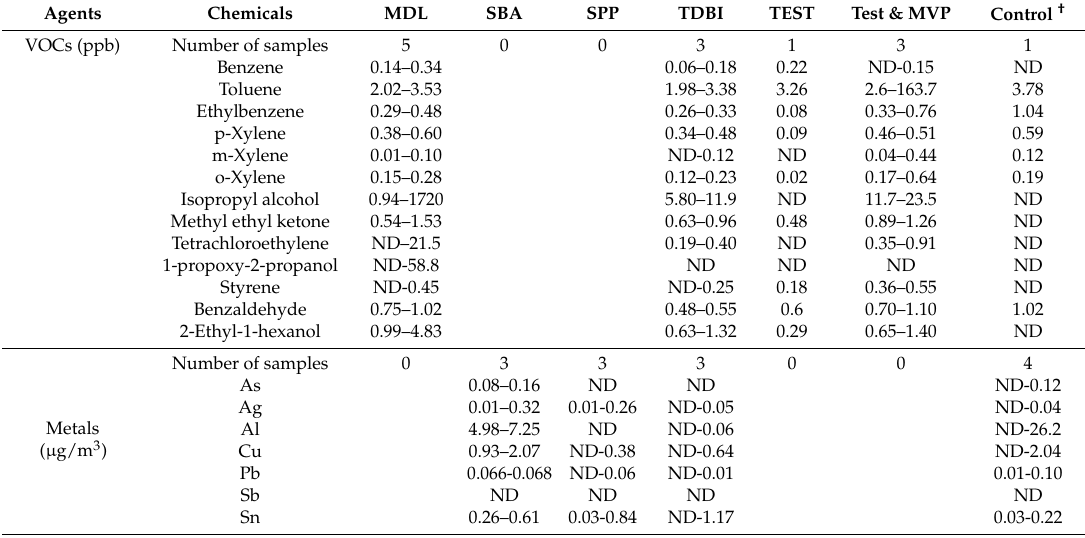
Table 4. Airborne volatile organic compounds (VOCs) and metal concentrations in package and test